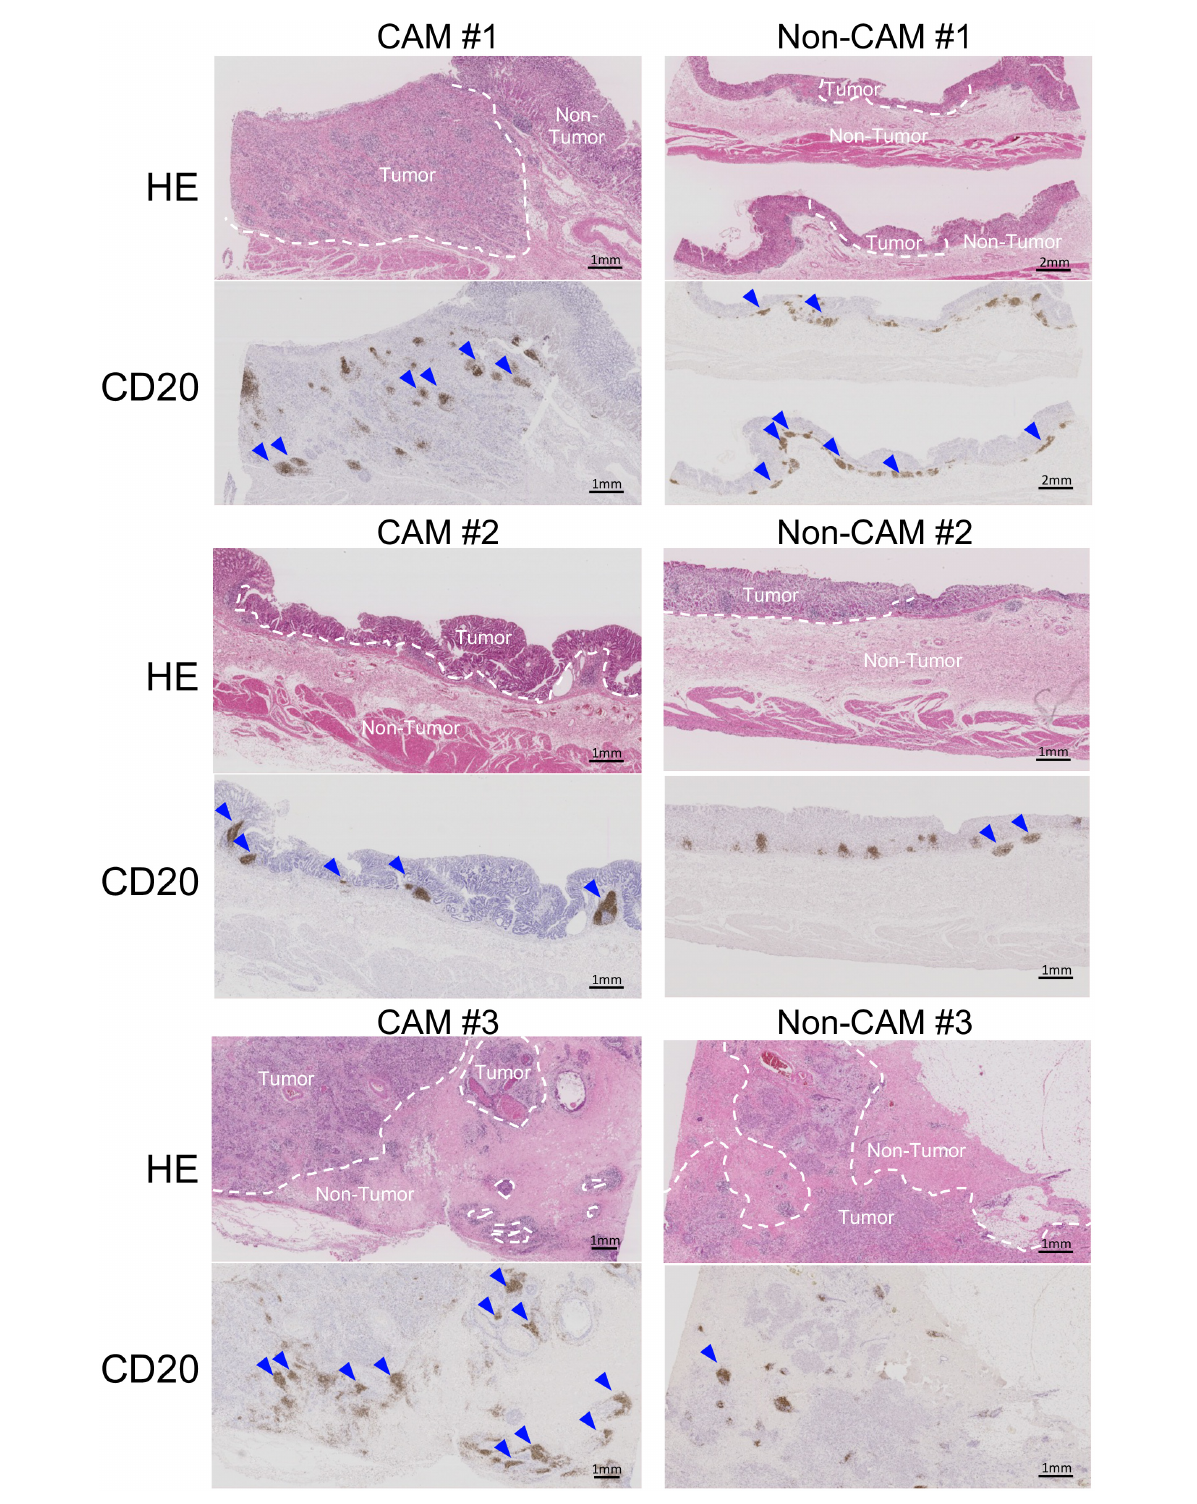
FIGURE4 Low-magnification images of TLSs in 3 CAM patients and 3 non-CAM controls. HE staining and CD20 immunostaining were conducted in sequential tumor sections in 3 CAM patients (CAM #1-#3) and 3 non-CAM controls (non-CAM #1-#3). Broken lines in HE staining indicate the border between the tumor and non-tumor lesions, while blue arrows show TLSs with CD20 + B-cell aggregates. Scale bar = 1 µ m (2 µ m in non-CAM #1) CAM, cancer-associated myositis; HE, hematoxylin and